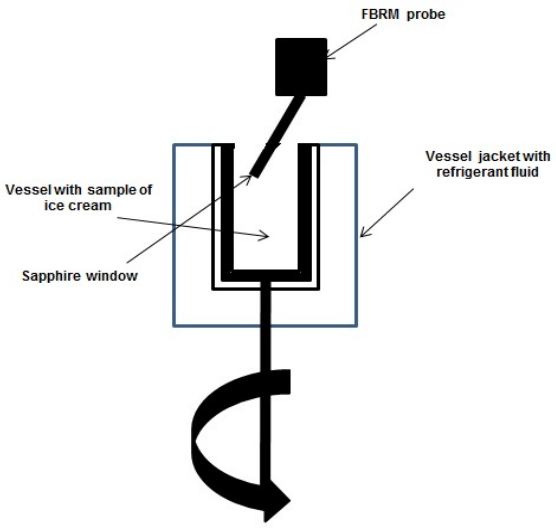
Figure 2. FBRM experimental device (own work, based on Amamou et al., 2010 studies [6]).